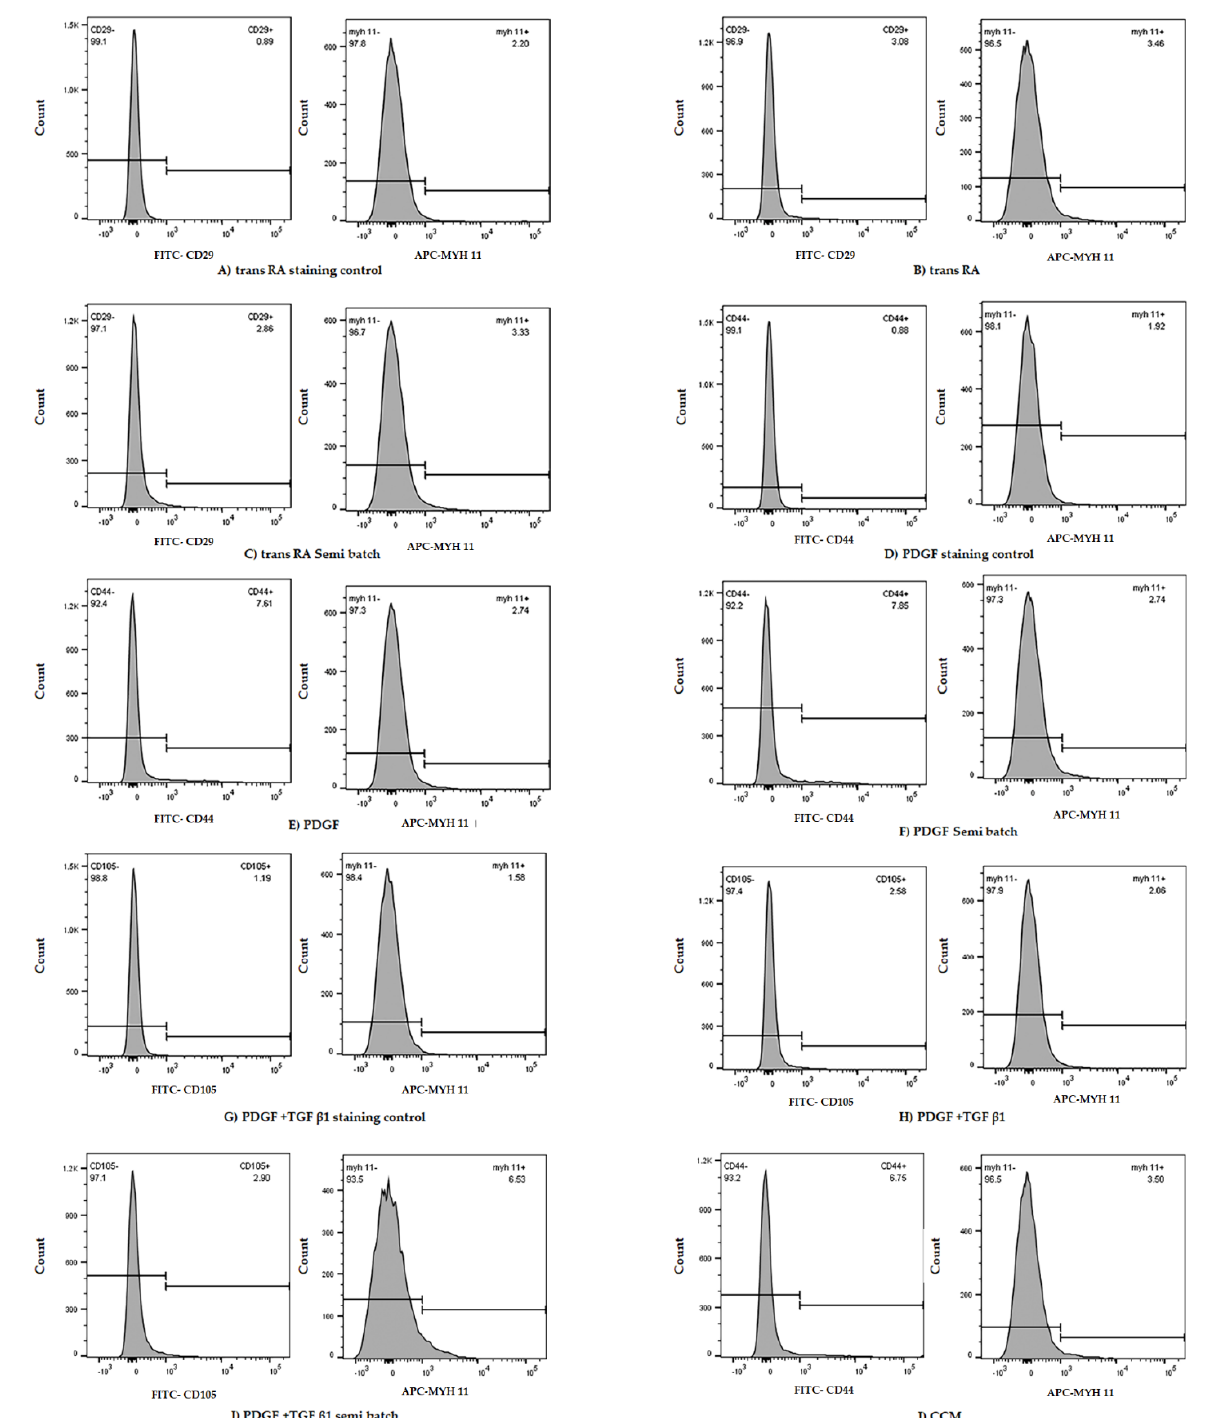
Figure 3. Representative flow cytometry data from M1 cell line subjected to 7 days in different DM treatments ( A – J ). Staining control samples were subjected to only secondary antibodies ( A , D , G ). Each non-control tube was stained with two primary antibodies which denoted SMC (MYH II) and MSC (CD29, CD44, CD105) markers, respectively ( B , C , E , F , H , I ). The cell line cultured in cell culture medium (CCM) is considered an experimental control. In this trial, the samples subjected to PDGF and TGF β 1 (semi-batch) (I) elicited the highest MYH11 expression. However, the difference in MYH11 expression was not significant in any of these cases (Figure 4). The results from the FlowJo data analysis for ADSC differentiation to SMC (4,7 days) indicated that, although the PT semi-batch treatment could elicit relatively